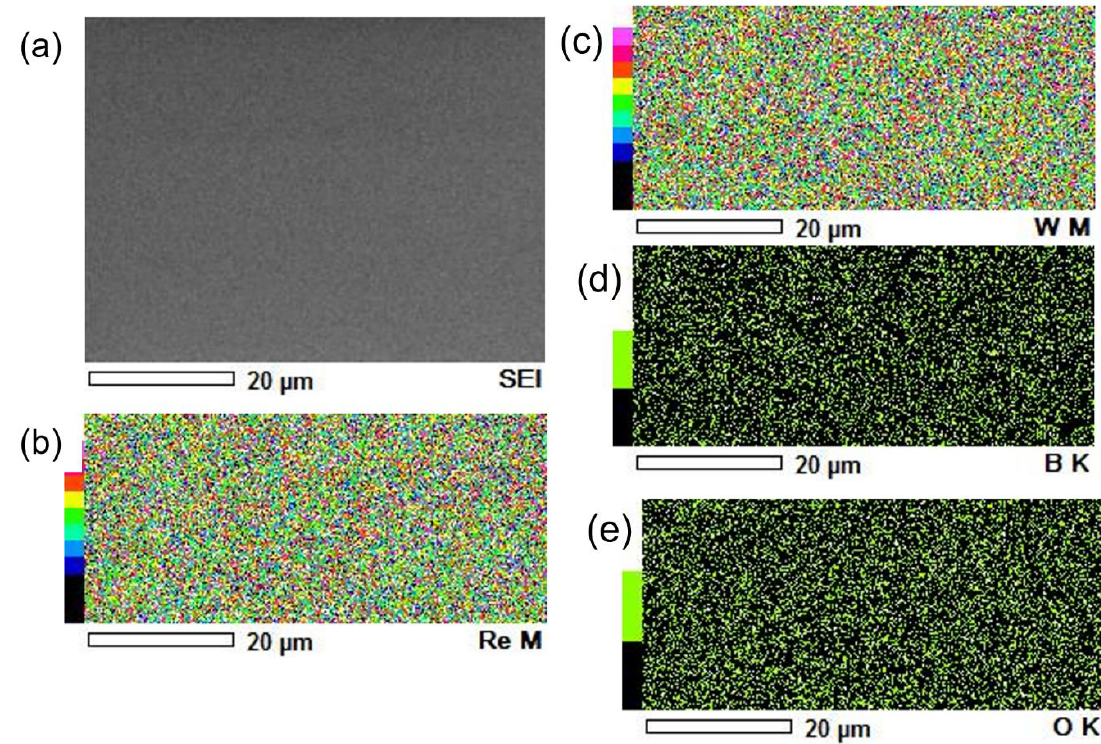
Figure 7. ( a ) SEM micrograph, EDS maps of elements: ( b ) Re, ( c ) W, ( d ) B, ( e ) O in the coating deposited from the W 0.76 Re 0.24 B 2.5 target.